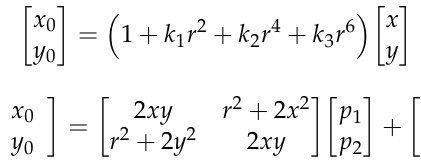
model of the tangential distortion is shown in (10).